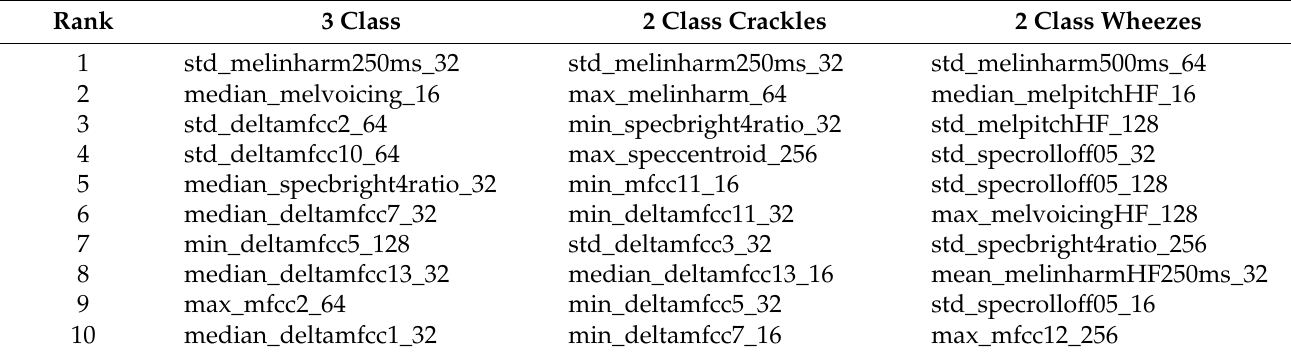
Table 6. Ten highest-ranked features (fixed